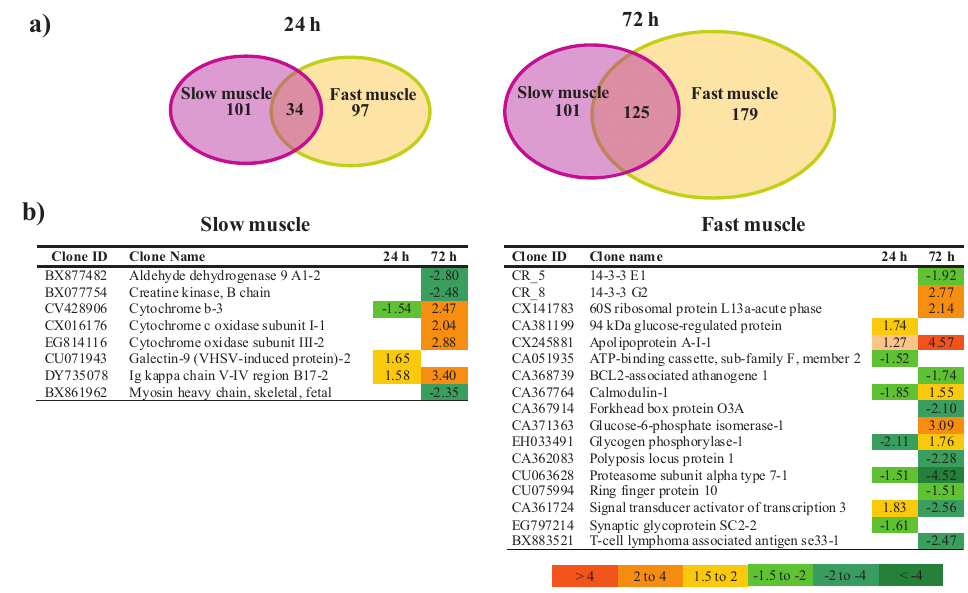
Figure 4. Muscle type-specific responses to lipopolysaccharide (LPS) administration in trout. ( a ) Venn diagrams showing the number of slow skeletal muscle differentially expressed genes (DEGs; p < 0.01), fast skeletal muscle DEGs, and common DEGs at 24 and 72 h